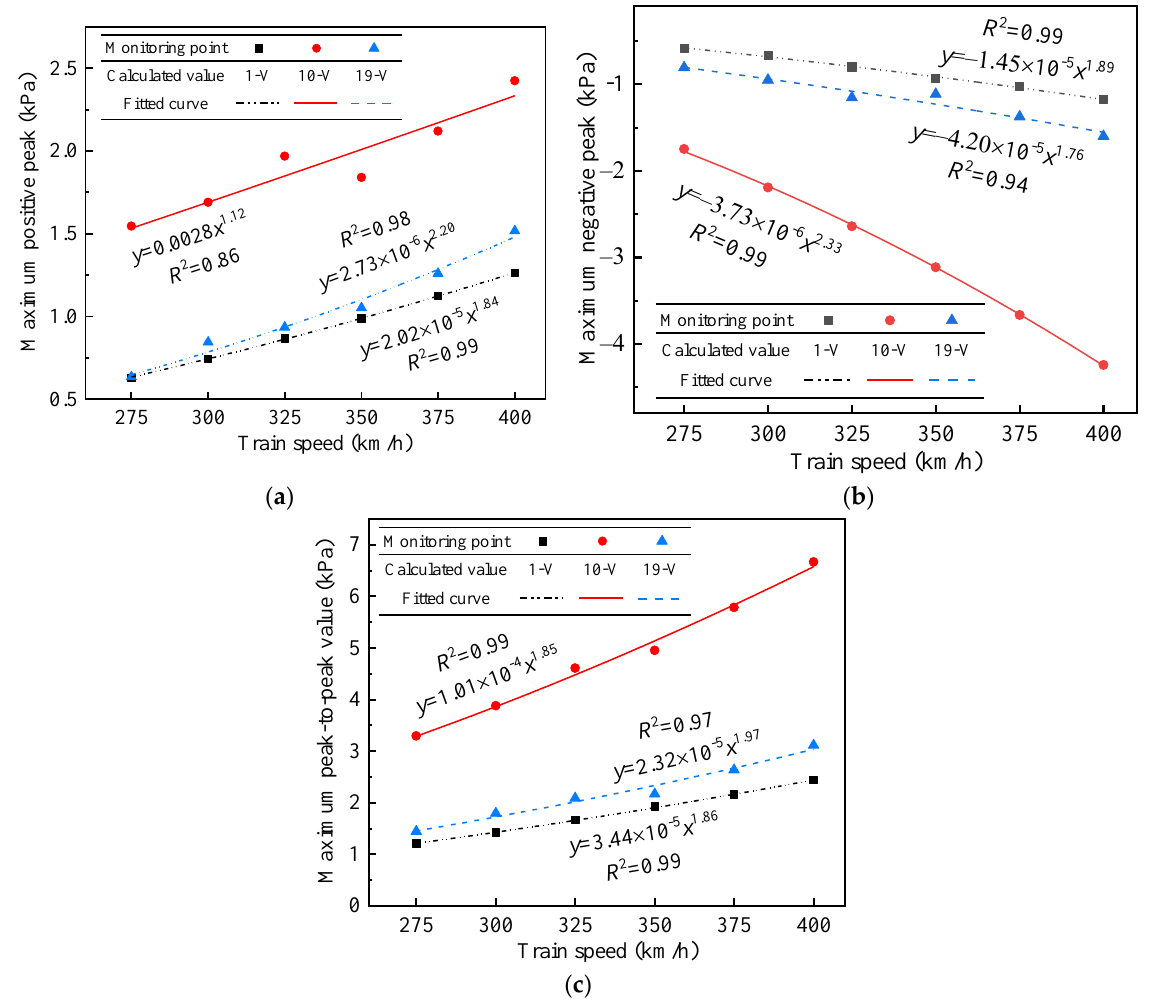
Figure 18. Maximum peak pressures versus train speed of typical monitoring points in Stage II. ( a ) Maximum positive peak; ( b ) Maximum negative peak; ( c ) Maximum peak-to-peak value.